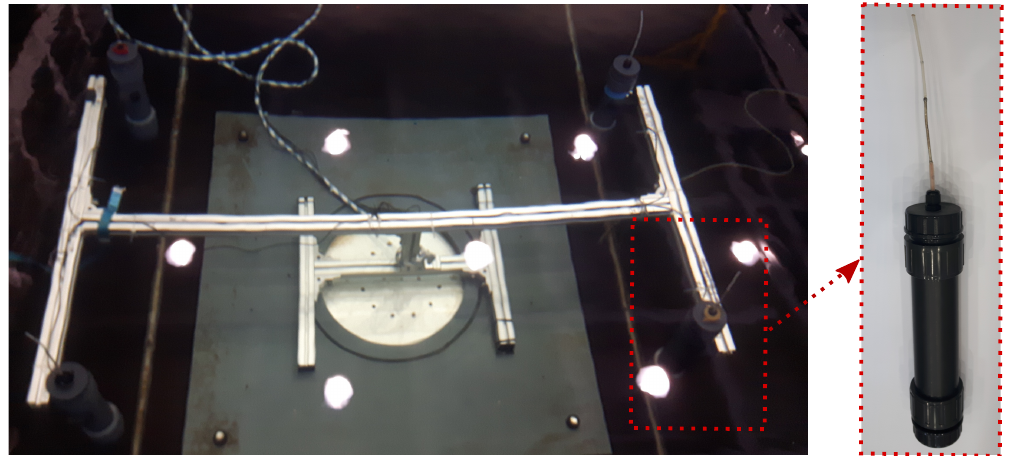
Figure 10. Submerged rack with four beacons. Each beacon contains a signal generating unit and continuously emits an EM signal at a unique